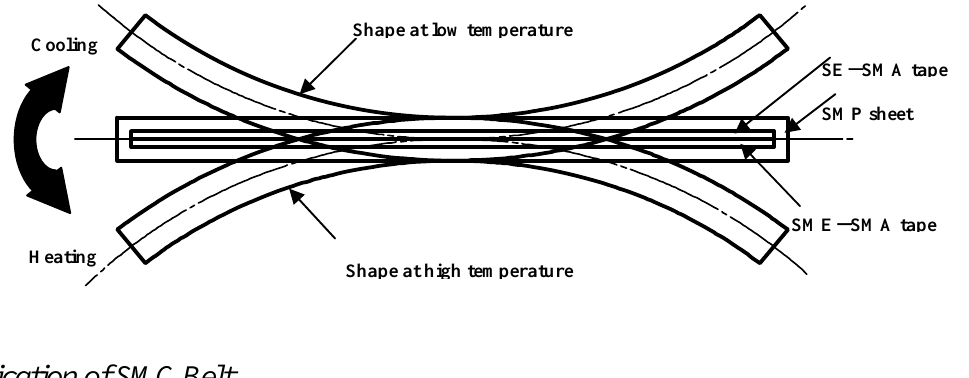
Figure 3. Principle of two-way bending behavior in SMC during heating and